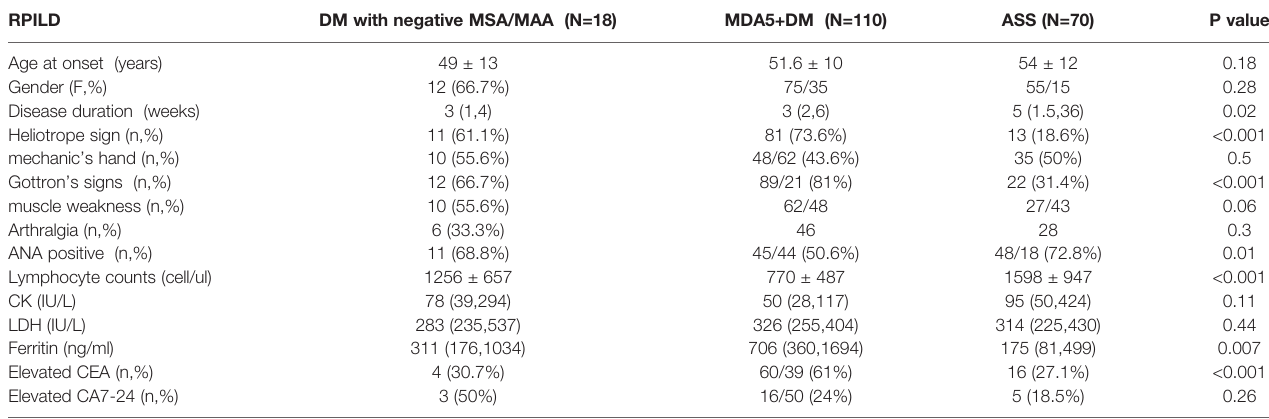
TABLE 3 | The comparison of clinical features among RPILD patients with negative MSA/MAA, anti-MDA5 and anti-ARS antibodies. RPILD DM with negative MSA/MAA (N=18) Age at onset